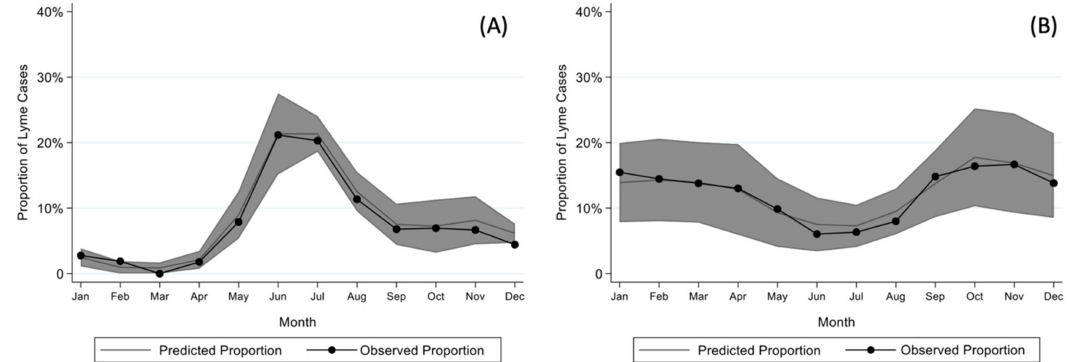
Figure 1. Model for seasonality of ( A ) early or early-disseminated and ( B ) late Lyme disease after adjusting for sex, age, year, and region as well as clustering by center with 95% confidence